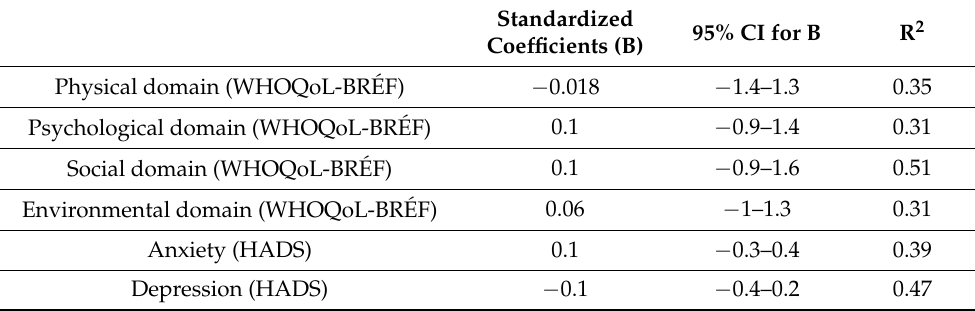
Table 4. Coefficients table for the impact of smell dysfunction on QoL and mental health well-being of the pSS